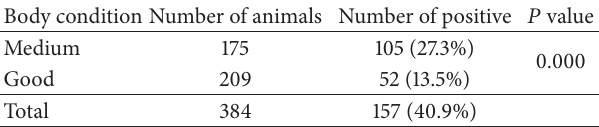
Table 1: Prevalence of Haemonchus in sheep based on body condition.